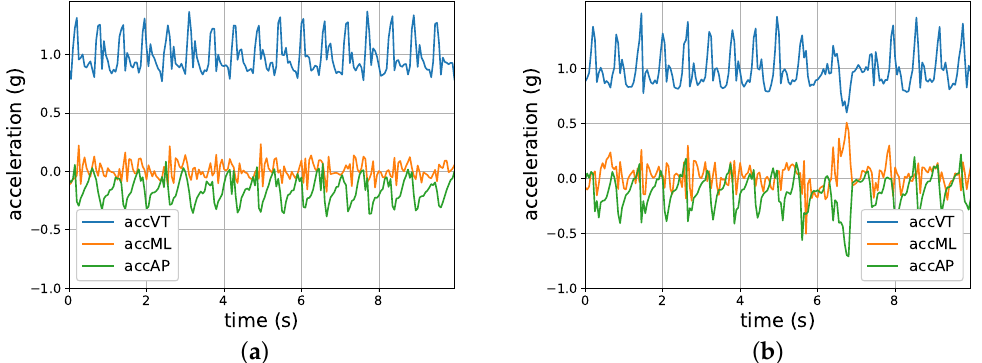
Figure 1. An example of two locomotion samples. ( a ) A typical walking sample; ( b ) A walking sample interwoven with a turning activity at 7 s. accAP: acceleration in the anteroposterior direction; accML: acceleration in the mediolateral direction; accVT: acceleration in the vertical